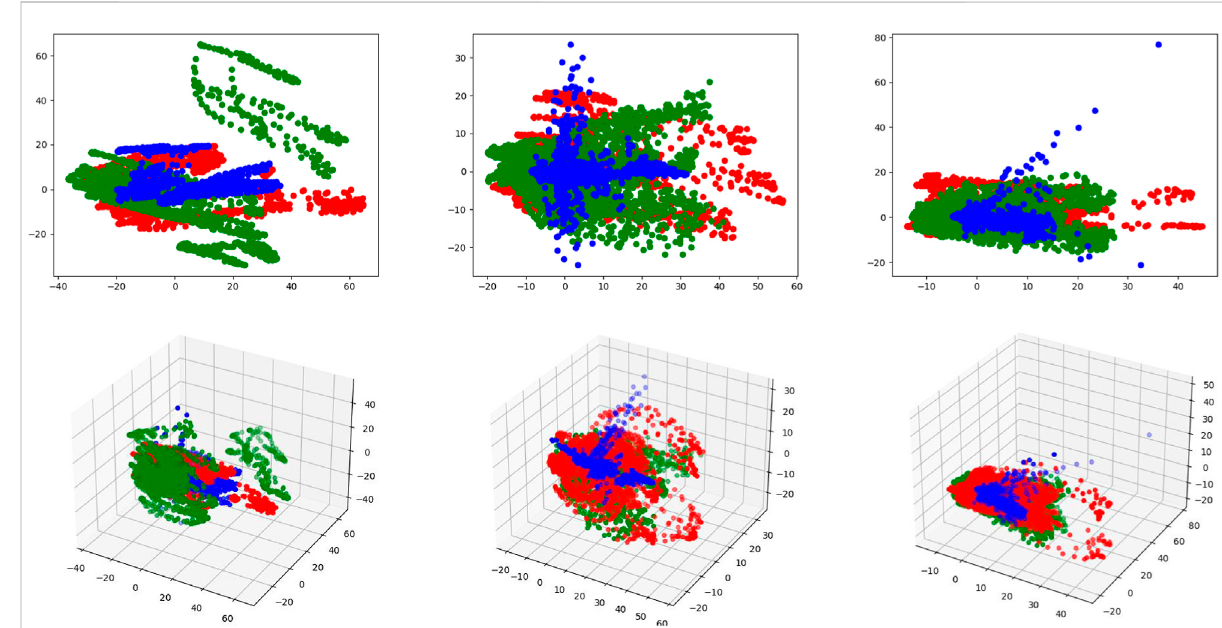
FIGURE 8 Visualizations of the unique and commonfeatures in 3Dand 2D latent spaces. Red and green points represent theunique features of two input modalities,andbluepointsrepresentthecommonfeatures.The fi rstrowrepresentsthe2Dlatentspaceandthesecondrowrepresentsthe3Dlatent space. From left to right, each column represents MAFFB 1 , MAFFB 2 , and MAFFB 3 ,